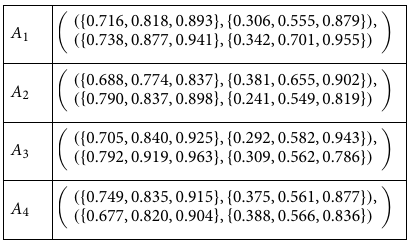
Table 7. Information aggregated utilizing FHFROWA.